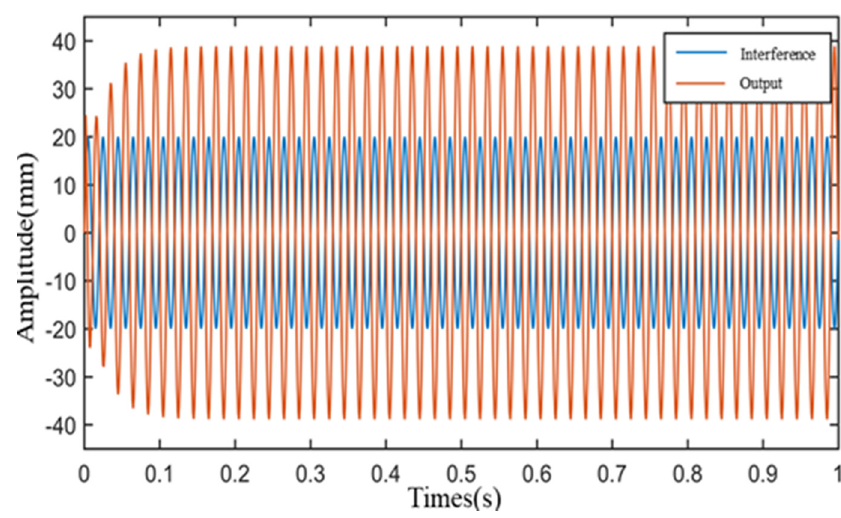
Figure 16. Simulation results of 50 Hz interference.